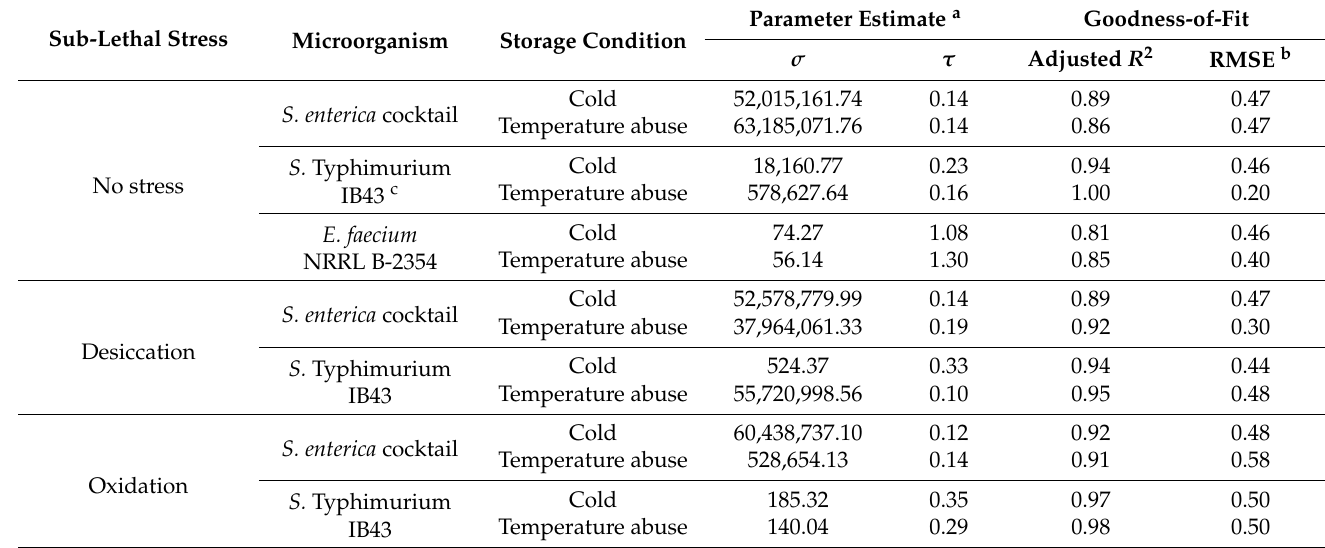
Table 3. Parameter estimates and goodness-of-fit of the Weibull model for the persistence of S. enterica and E. faecium NRRL B-2354 on baby spinach under cold and temperature abuse conditions with or without prior exposure to sub-lethal